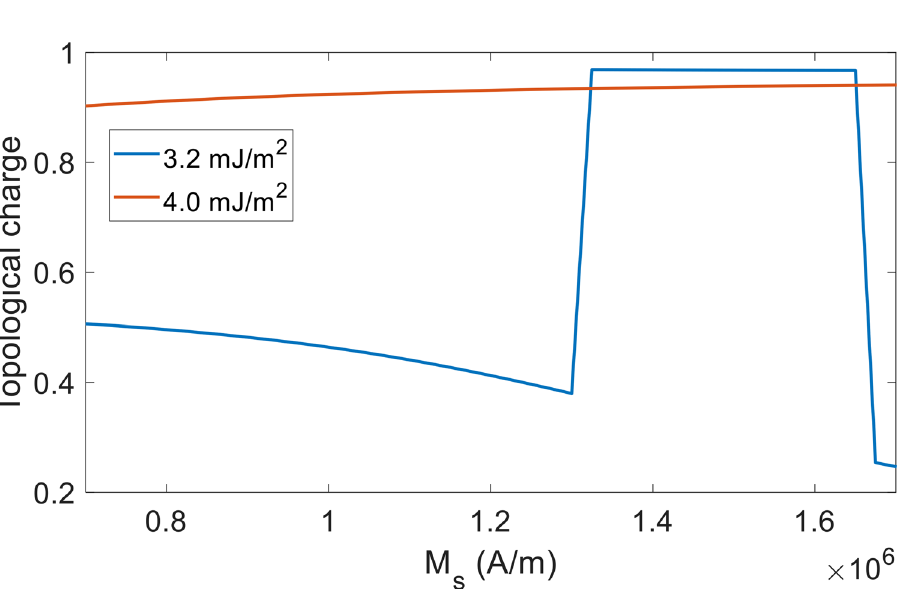
Figure 4. Topological charge vs. saturation magnetization of 20 nm nanodot for 3.2 mJ/m 2 and 4.0 mJ/m 2